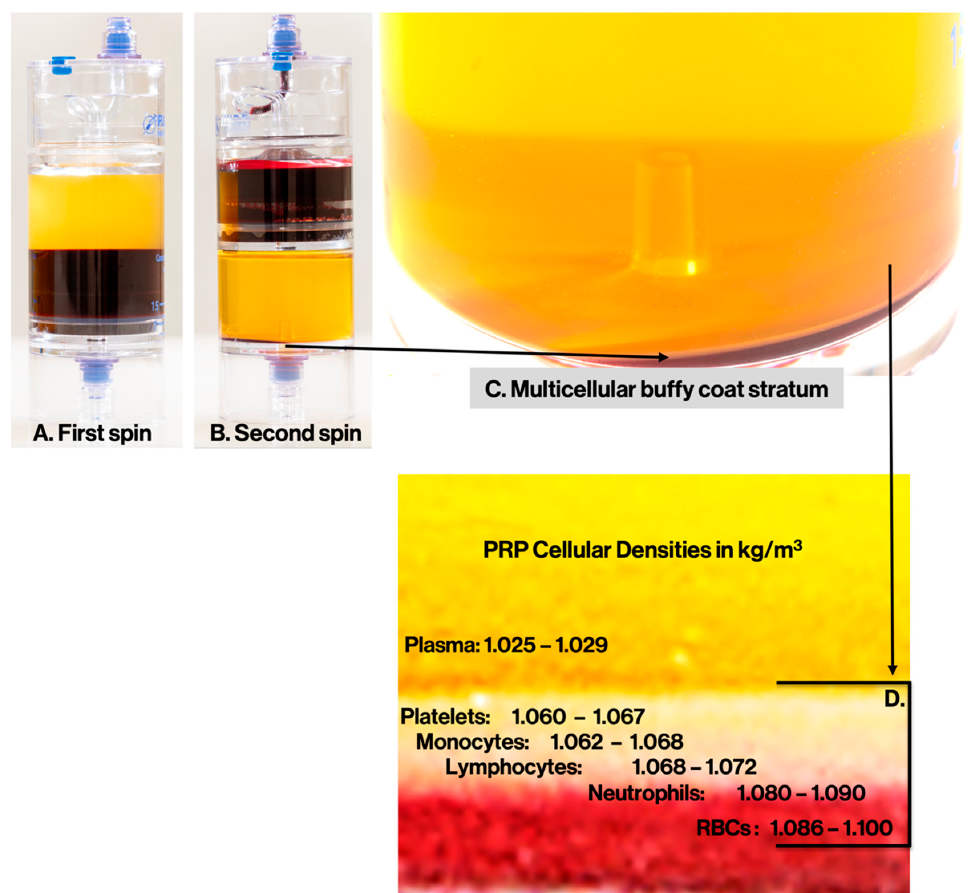
Figure 2. Multicellular Density Separation after a Double-spin PRP Procedure. Graphical presentation of the cellular gravitational density separation using a 60 mL PurePRP-SP ® device (Used with permission from EmCyte Corporation, Fort Myers, FL, USA). After the first spin ( A ), the whole blood is sequestered in a top layer (plasma fraction), an intermediate thin layer (multicomponent buffy coat, including platelets and leukocytes), and a bottom layer consisting of RBCs. After the second spin ( B ), all cells are concentrated at the bottom of the second compartment of the PRP device. In ( C ), after a magnification of the second compartment after the second spin, the multicellular buffy coat stratum (grey layer on top of the RBCs). Further enhancement, ( D ) picture, indicates the representation following cellular gravitational density separation, according to the specific densities of the individual cells [94]. Caveat: note the overlap in the range of cellular densities of the various cell types.